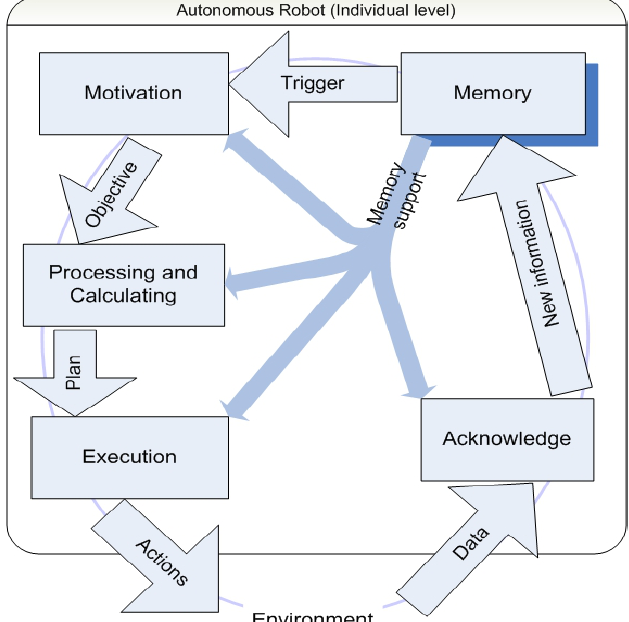
Figure 2. Information flow for an autonomous